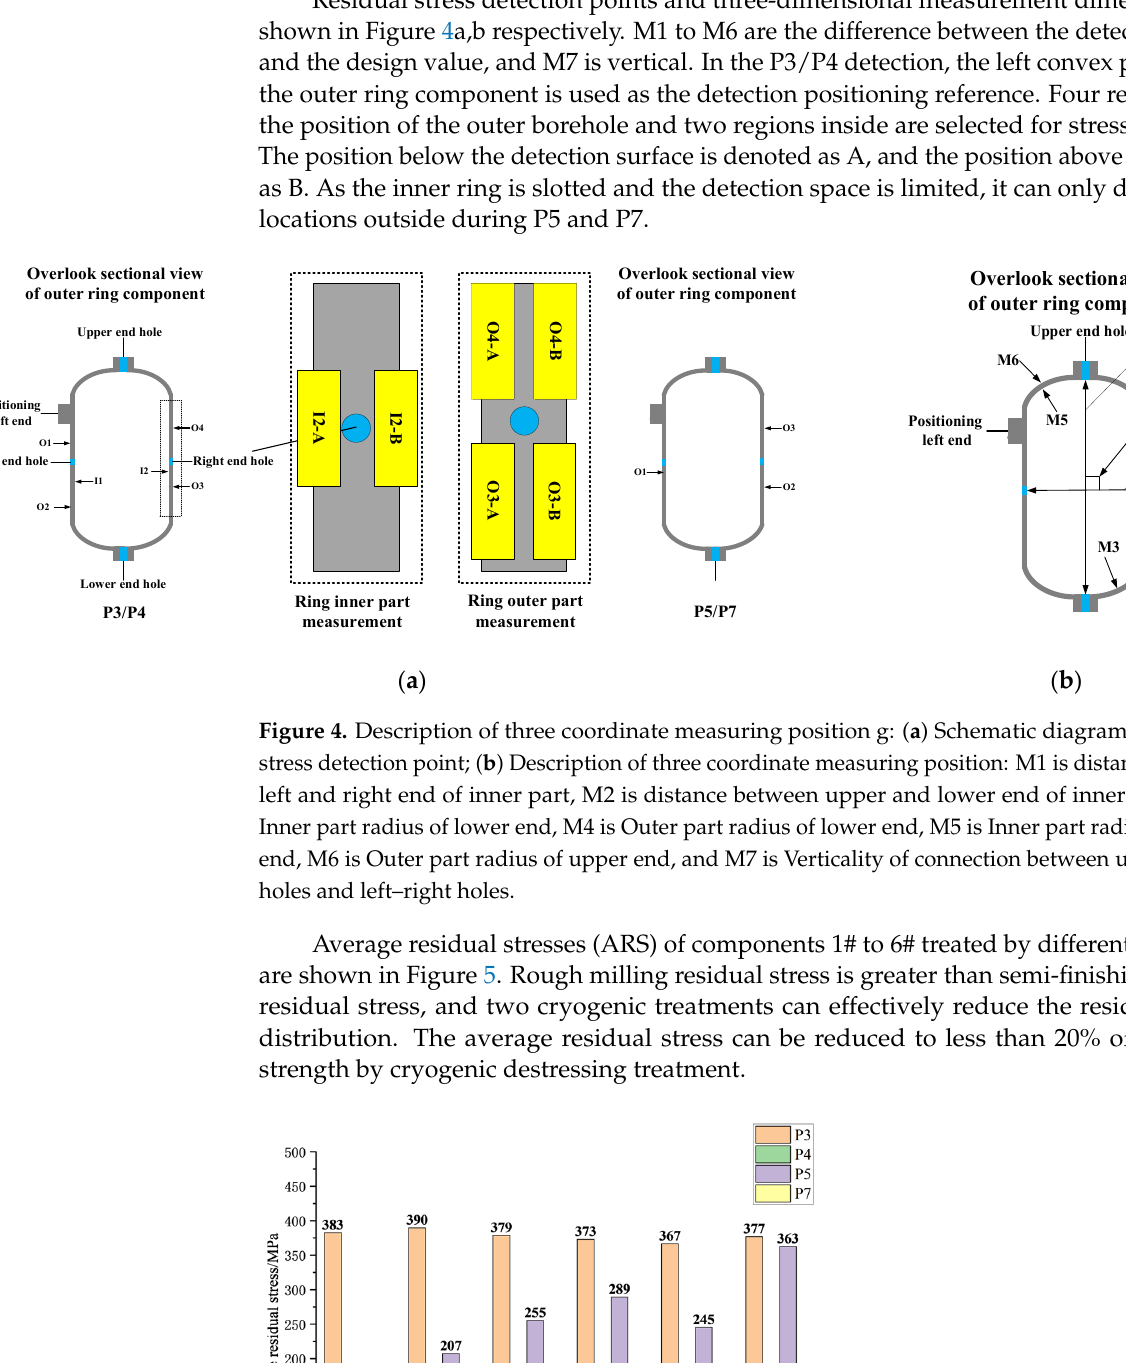
( b ) Figure 6. Residual stress distribution and deformation of 1# under different processes: ( a ) Residual stress; ( b ) Deformation. The deformation of the component 1# from rough milling to the second cryogenic treatment is shown in Figure 6b. Since there is no fixed tooling to limit the deformation in the process of cryogenic stress relief, the component in the free state also induce secondary deformation during stress is released. The variation trends of the distance between the left and right/upper and lower and the inner and outer radius are not consistent. The maxi- mum deformation size after rough milling is M4 (outer part radius of lower end), followed by M2 (distance between upper and lower end of inner part) and M6 (outer part radius of upper end). The verticality error is caused by the inward contraction of the outer radius of the upper and lower ends. After the first cryogenic treatment, the deformation of M4